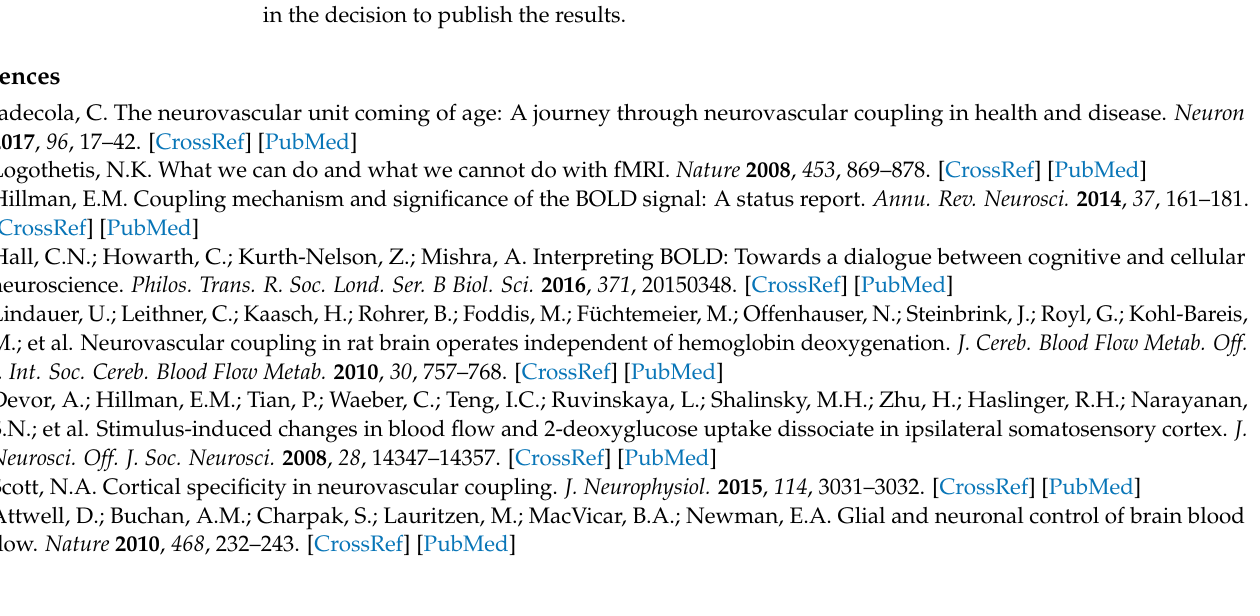
Table S1: Maximal capillary dilations at different stimulation frequencies; Table S2: N2a and N2b peak amplitude changes at the end of the